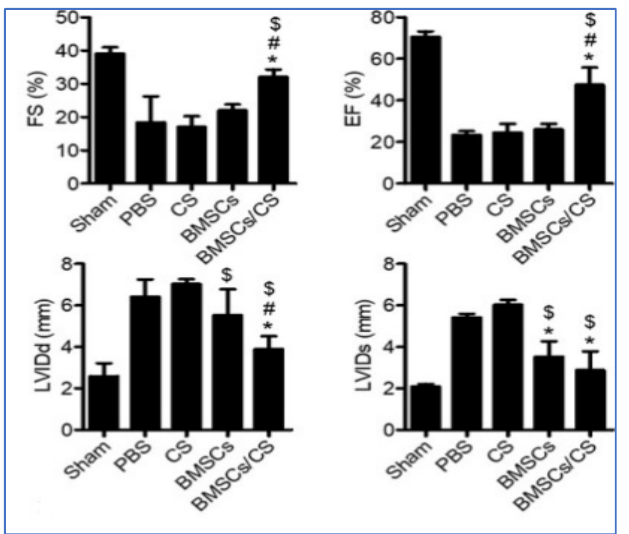
Figure 7. The levels of EF%, FS%, LVIDd, and LVIDd were evaluated using echocardiography (n = 12). The results suggested that co-transplantation of BMSCs with CS hydrogel significantly improved cardiac function. Data expressed as mean ± SEM. n = 8. * p < 0.05 versus BMSCs, # p < 0.05 versus BMSCs, $ p < 0.05 versus CS [81].